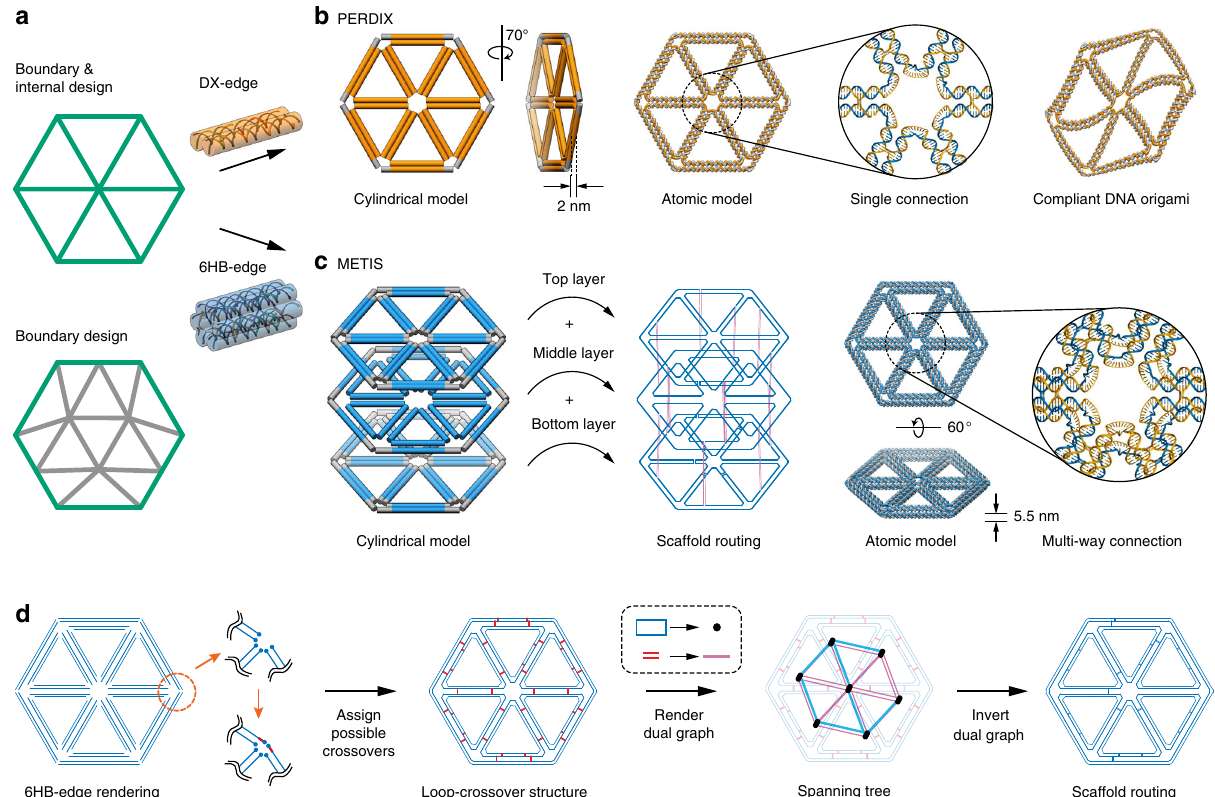
Fig. 1 Design of 2D wireframe scaffolded DNA origami objects with DX and 6HB edges. a Arbitrary target geometries can be speci fi ed as input in one of two ways: Boundary and internal design, specifying the complete internal and boundary geometry using piecewise continuous lines; or Boundary design, de fi ning only the border of the target object, with the internal mesh geometry designed automatically. b DX-based 2D wireframe scaffolded DNA